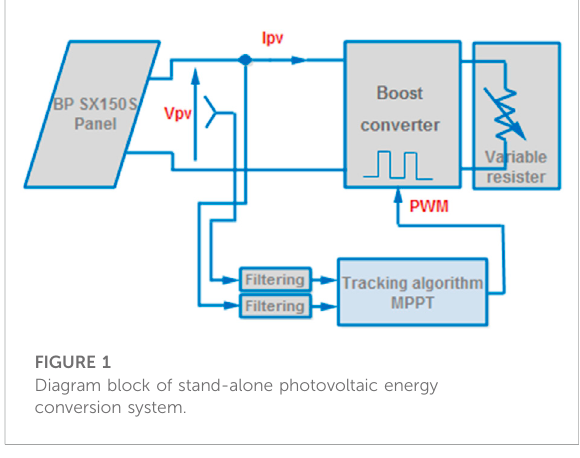
FIGURE 1 Diagram block of stand-alone photovoltaic energy conversion system.